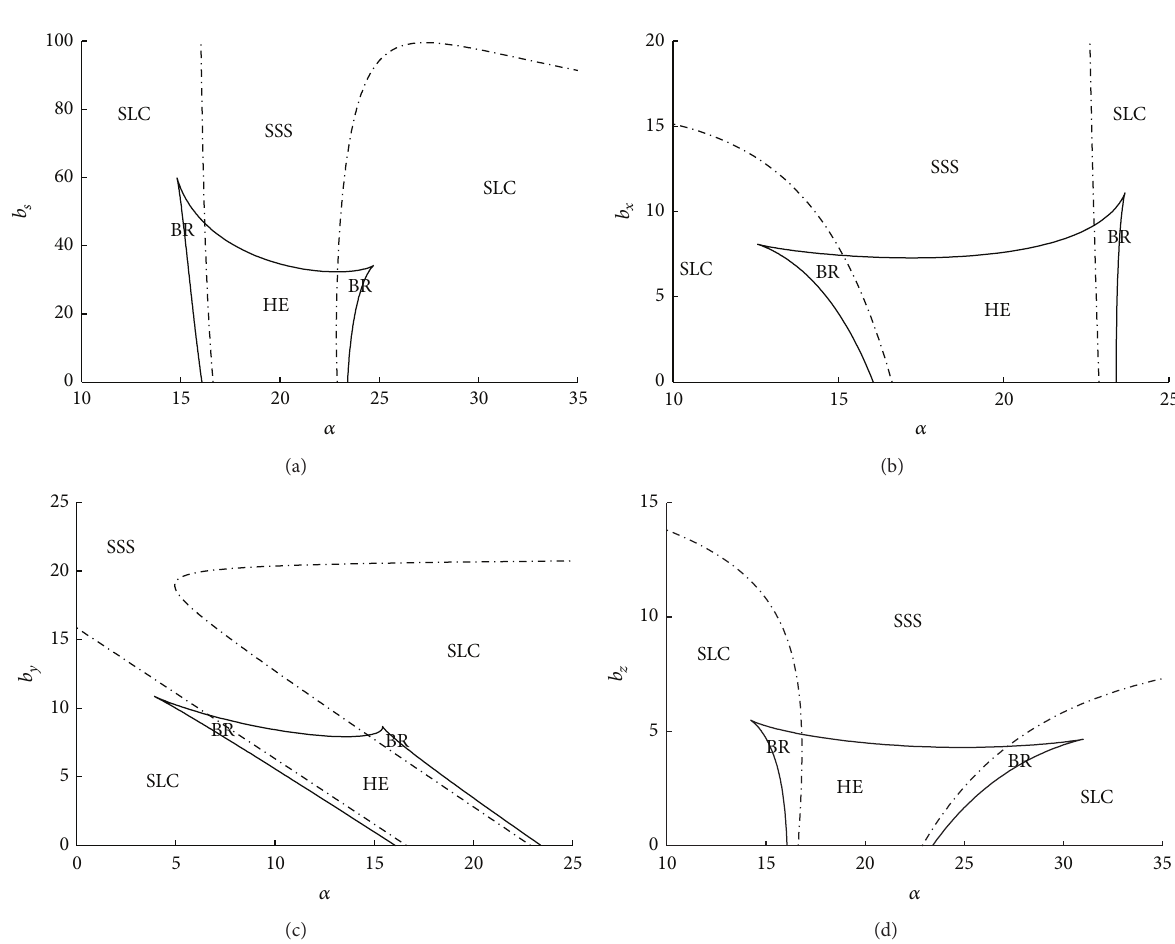
for 𝛼 versus 𝑏 𝑠 are U-shape in model (1) while being reversed U-shape in model